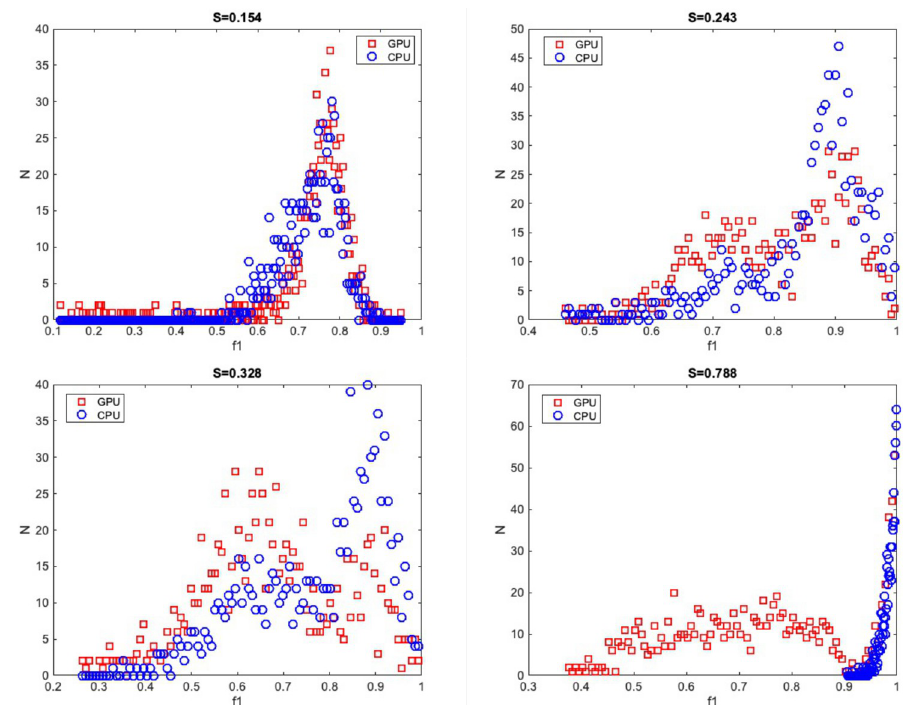
Fig 3. Example PDF distribution shape difference of f 1 . Example PDF distribution shape differences of significantly different f 1 .